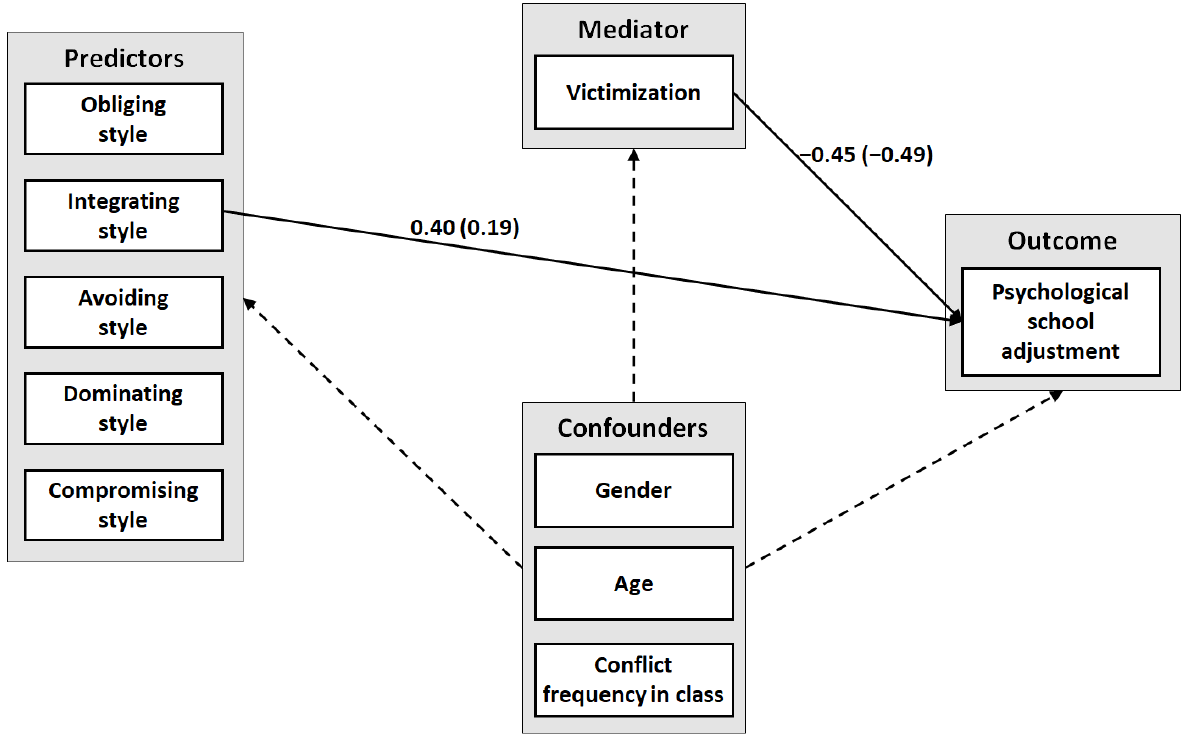
Figure 2. Mediation Model: The Effect of Conflict Management Styles on Psychological School Ad- justment with Bullying Victimization as Mediator Variable. Note. Mediation analysis was computed using JASP [72]. Solid paths and path coefficients represent significant loadings ( p ≤ 0.05). Loadings are unstandardized coefficients with standardized coefficients in parentheses. Table 2. Total, Direct, Total Indirect and Indirect Effects of Victimization Mediating the Association Between Conflict Management Styles and Psychological School Adjustment.